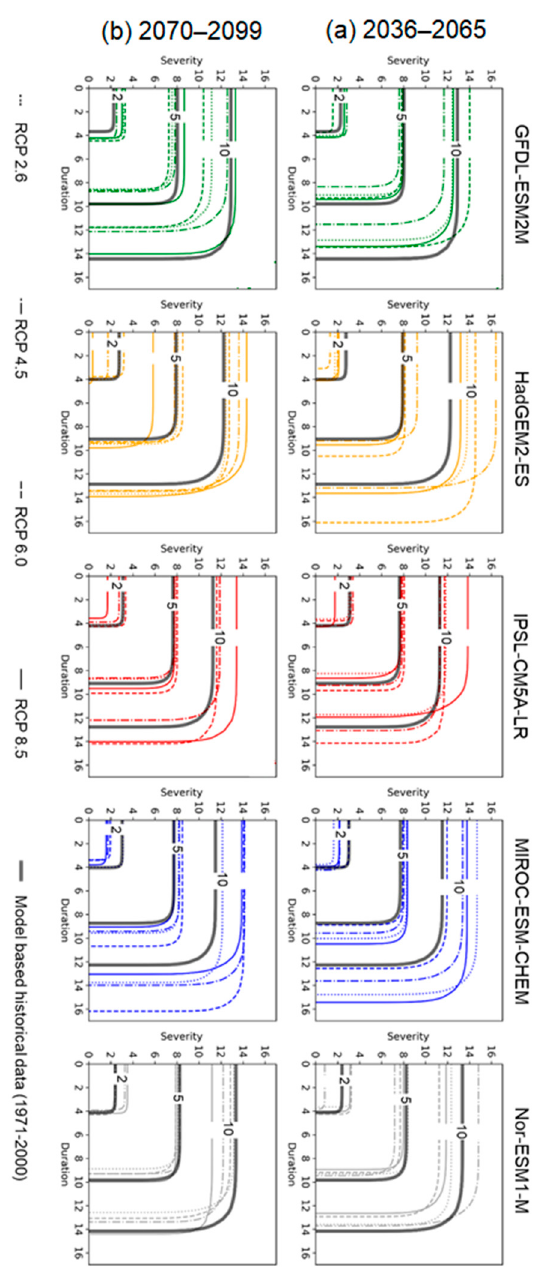
Figure 5. Bivariate interrelationships of duration–severity for return periods 2, 5, and 10 years for the mid ( a ) - and end ( b )-century and four RCPs separated for GCMs.